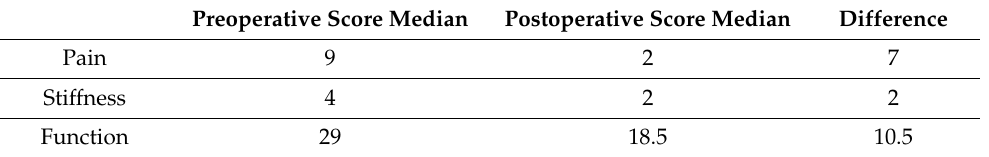
Table 4. WOMAC scores.